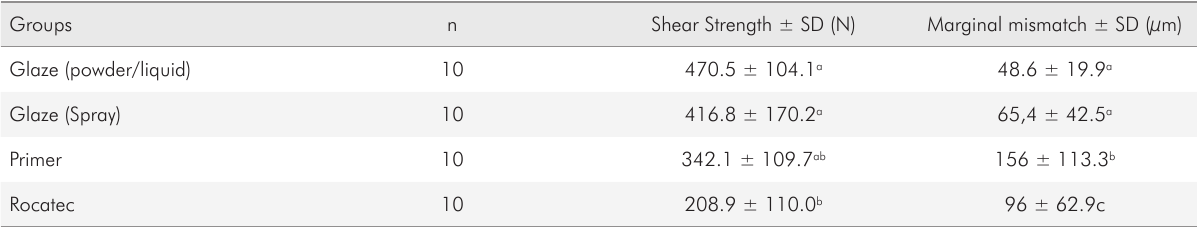
Table 2. Tukey’s test results for tensile strength (n) and ANOVA for marginal misfit ( μ m). Groups